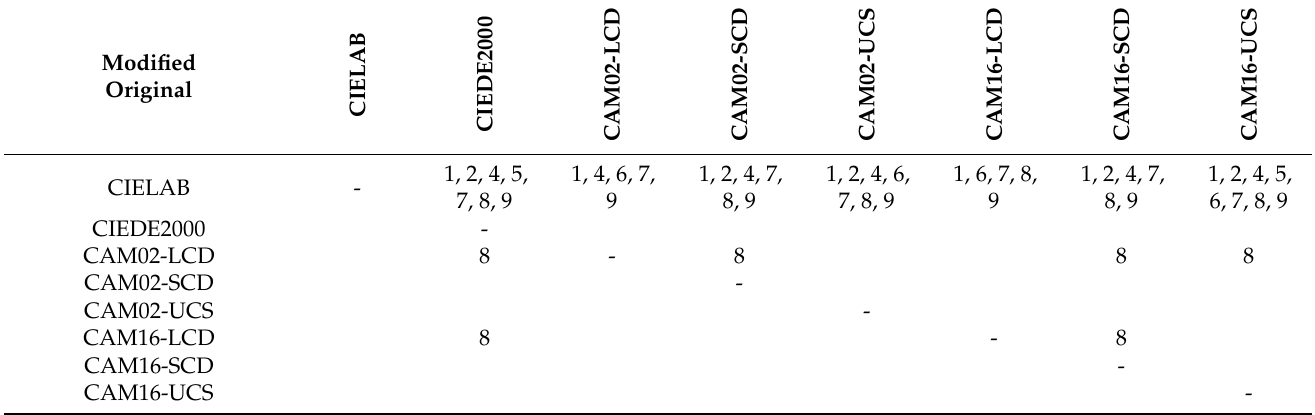
Table 11. Results from F-tests [25] showing the phases with statistically significant improvements of the modified color-difference formulas obtained using the parameters shown in Table 9 with respect to the original formulas (Table 3). Only for the phases indicated were the formulas in the first row significantly better statistically than the formulas in the first